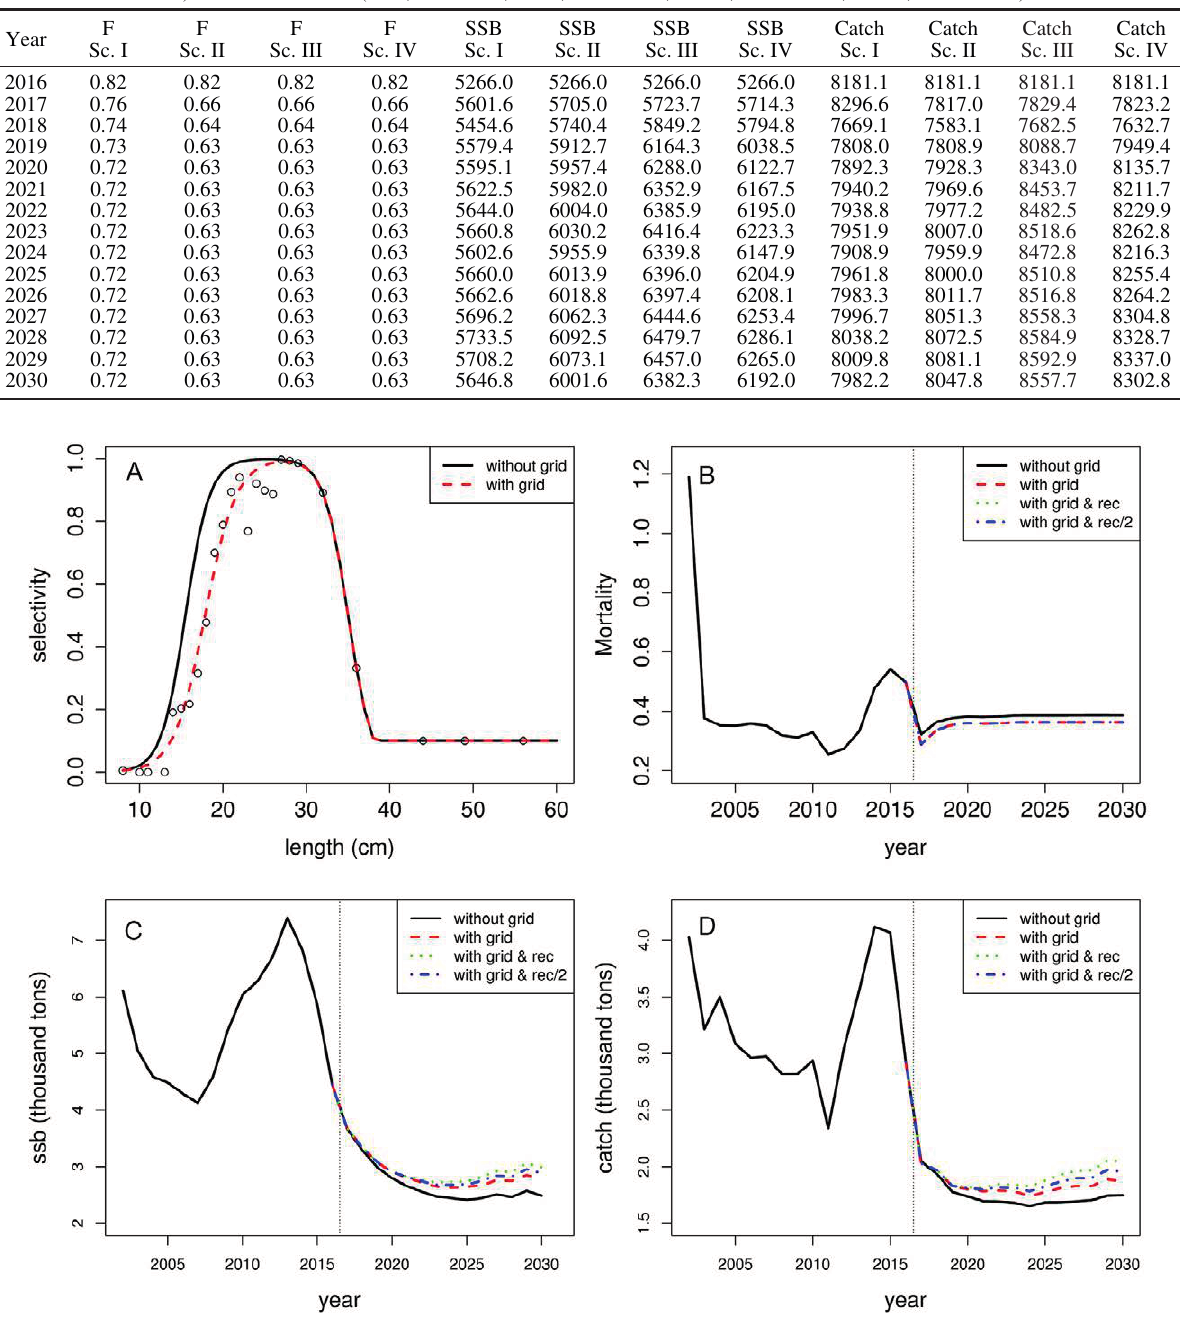
Fig. 6. – Gadget simulations plots of HKE comparing the trawl nets without grid (Scenario I, black solid line) and with grid (Scenario II, red dashed line; Scenario III, green dashed line; Scenario IV, blue dashed line). A, selectivity curves of HKE; circles represent the new proportions of specimens, by length class, retained by the net with grid, forecast up to 2030; B, fishing mortality (F); C, spawning stock biomass (SSB); D,